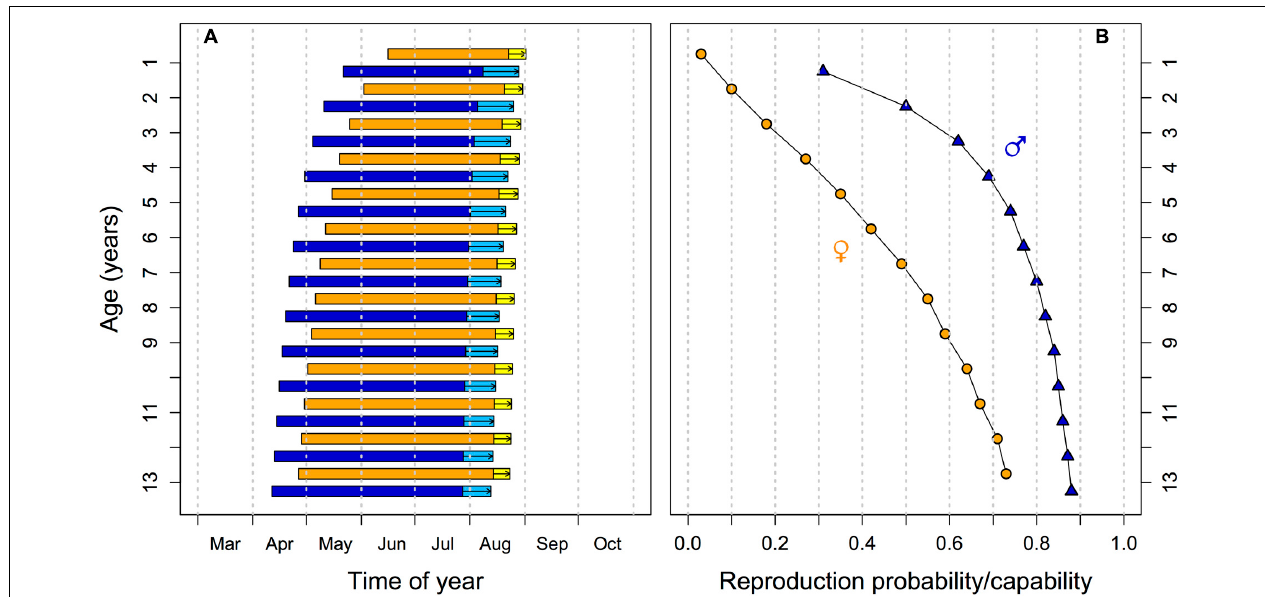
FIGURE 1 | Effects of age on (A) the timing of hibernation and activity and (B) on reproduction in yearlings and adult edible dormice. (A) As age increases both emergence from hibernation and hibernation onset occur earlier in the year, leading to a phase advancement of the active season (horizontal bars; blue: males; orange: females). Investment into reproduction leads to a delay in hibernation onset in both sexes (light blue and yellow bars with arrows). (B) The proportion of sexually active males with large testes (blue triangles) and of reproducing females (orange circles) increases with age. Predictions from multilevel models are based on data in Bieber et al. (2018).